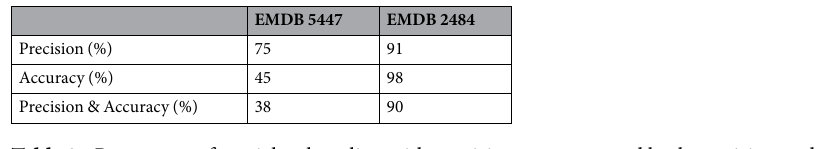
Table 2. Percentage of particles that align with precision, accuracy and both precision and accuracy for the HIV-1 trimmer with EMDB codes 5447 (a) and 2484